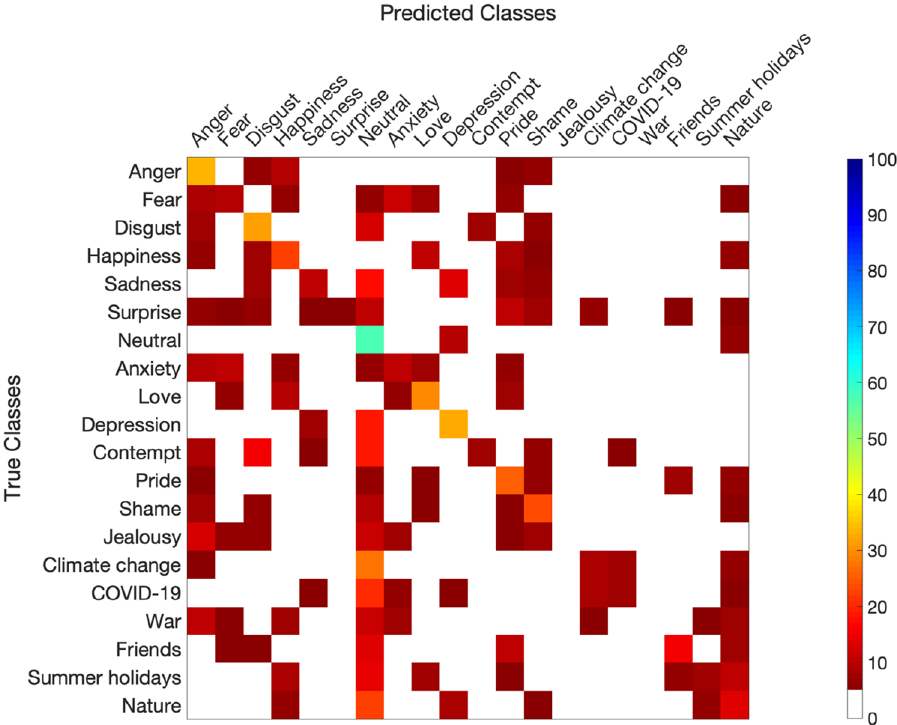
Figure 7. Confusion matrix between predicted and true classifications. White spaces represent classifications below chance level